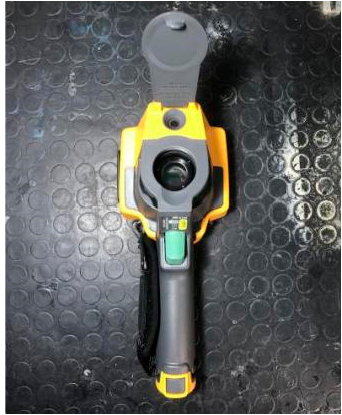
Figure 2. Infrared thermal imager.